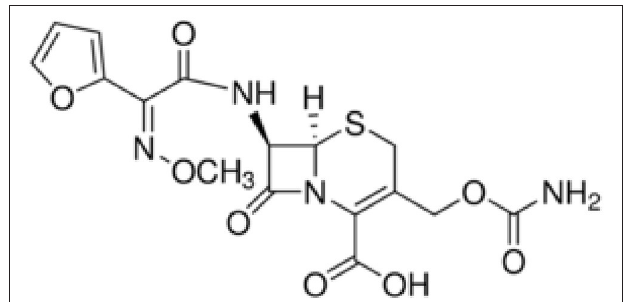
FIGURE 1 | Chemical structure of cefuroxime.